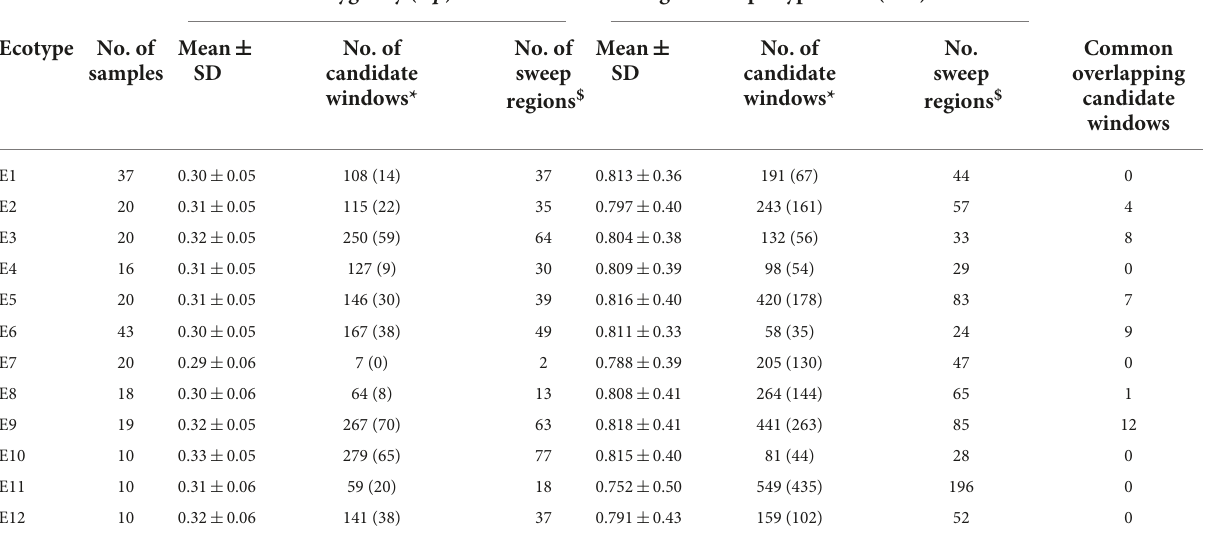
No. of sweep regions $